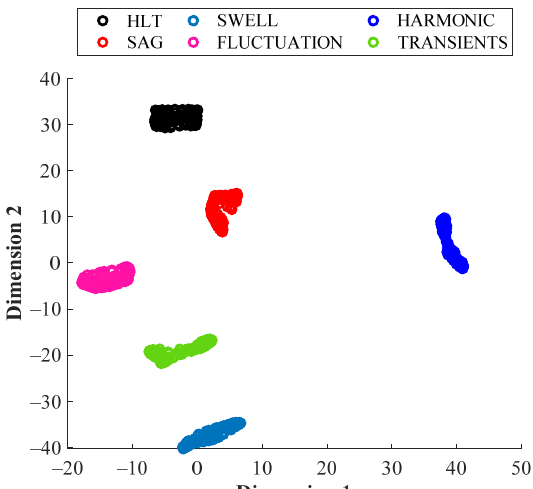
Figure 8. 2- d visual representation of the data distribution performed by the T-SNE technique over the resulting SOM neuron grid models for all considered conditions when analyzing all SOM neuron grid models from the three analyzed domains, TD, FD and TFD.